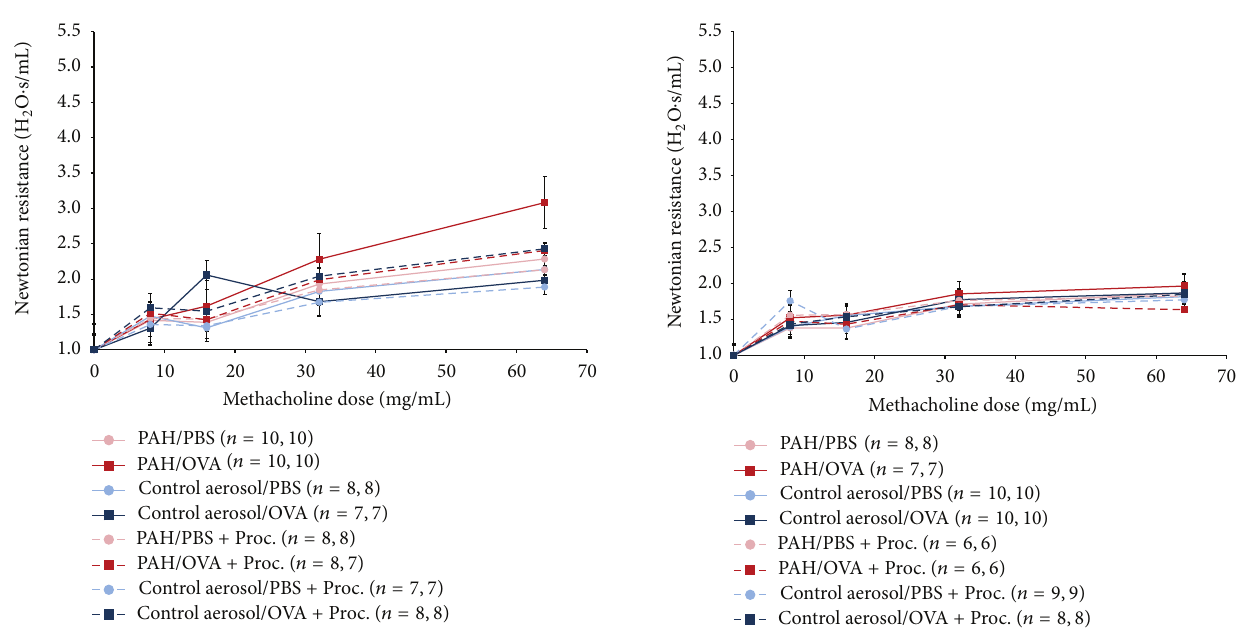
Figure 5: AHR following postnatal PAH exposure in the presence and absence of procaterol in 𝛽 2 AR (−/−) DKO mice. There were no significant differences between the OVA sensitized/OVA challenged and the PBS sensitized/OVA challenged mice in either PAH or nor- mal air exposure ( P = NS). Clear improvement across experimental groups following administration of procaterol is not evident. Table 3: 𝛽 2 AR gene expression in lungs.